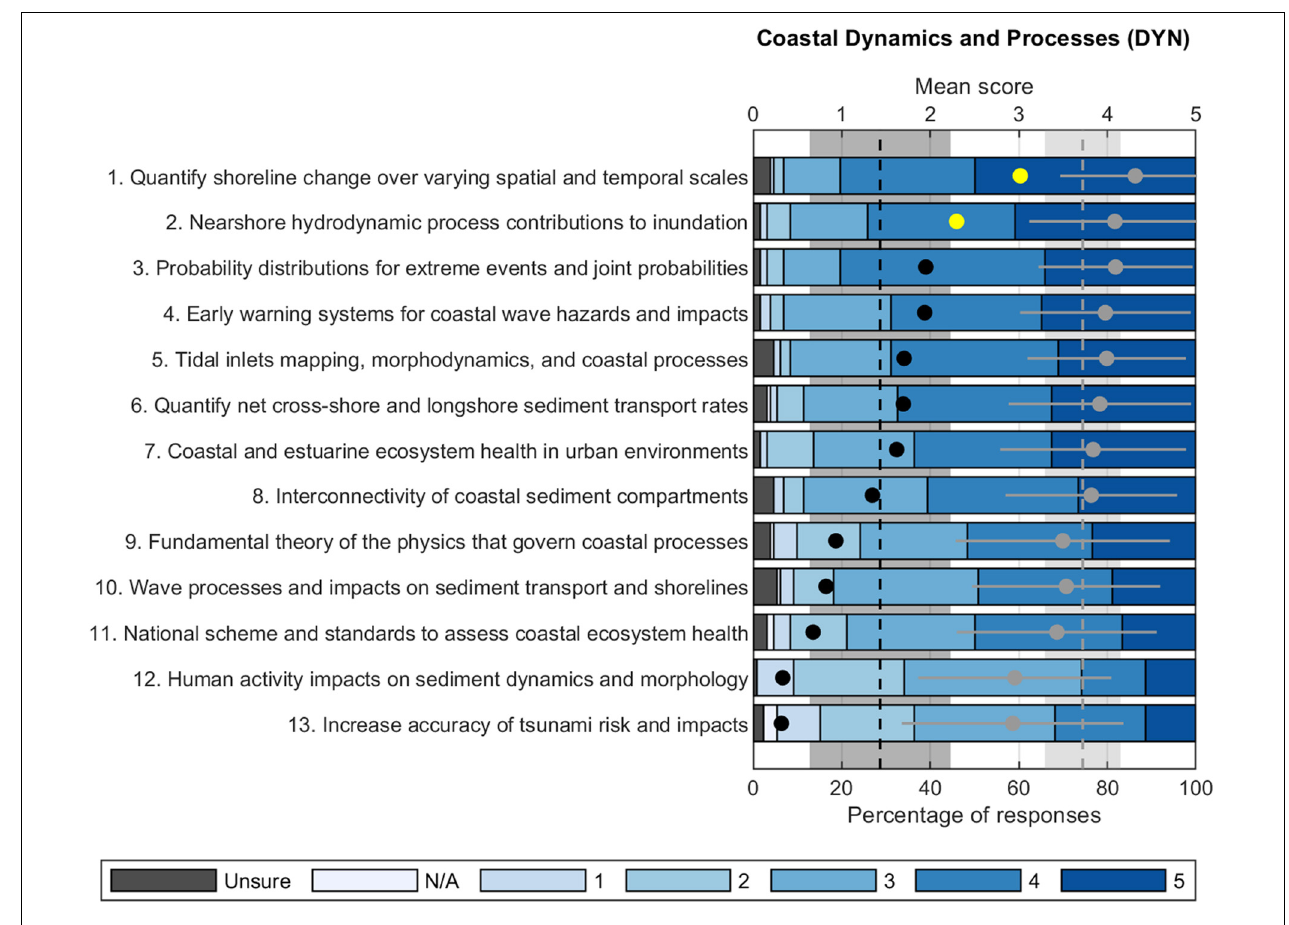
FIGURE 6 | Stacked bar plot showing the distribution of Stage 3 respondent scores for priorities in the Coastal Dynamics and Processes (DYN) category. See Figure 5 for full